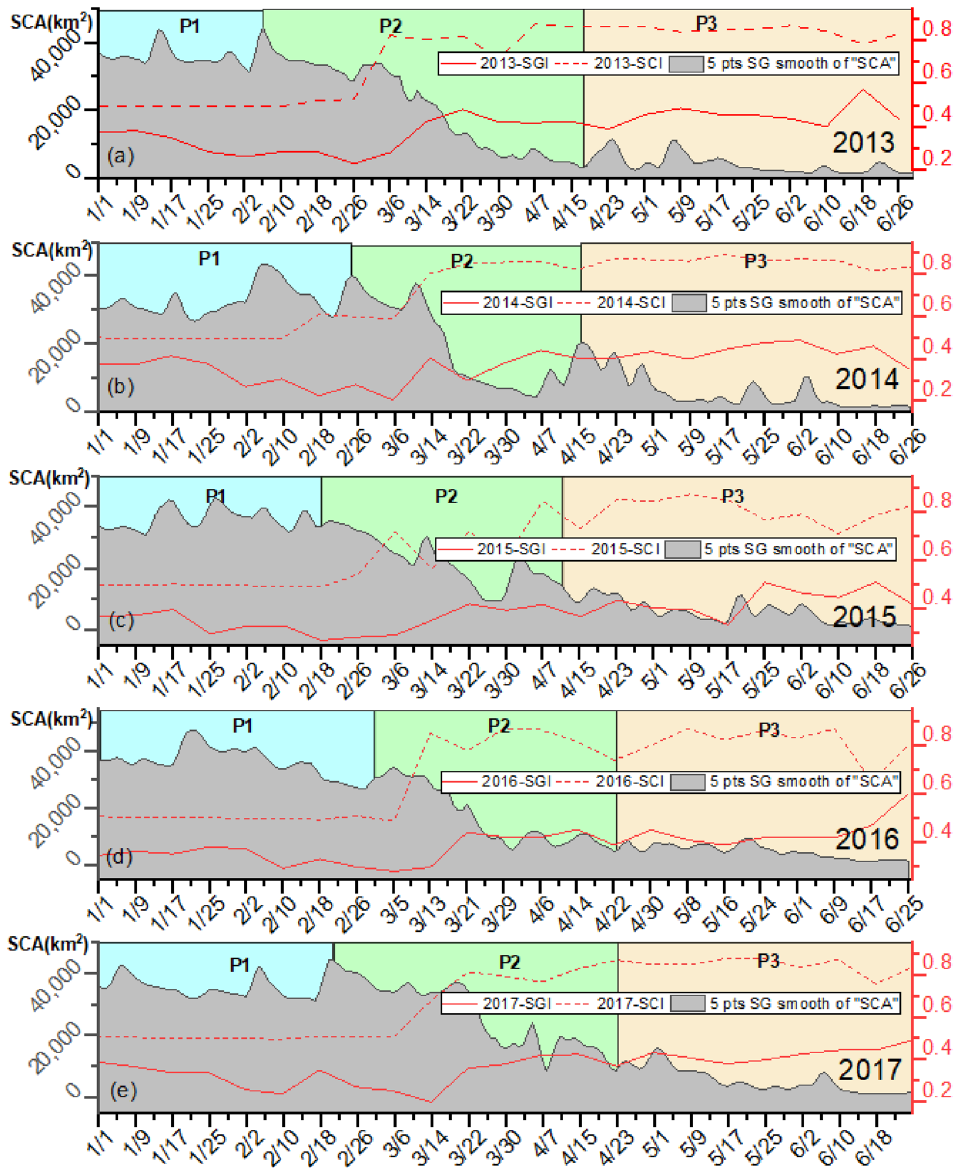
Figure 3. Variations in the SCA, SGI, and SCI during snowmelt seasons from 2013 to 2017. Map created in OriginPro, Version 2021. OriginLab Corporation, Northampton, MA, USA. (https:// www. origi nlab.